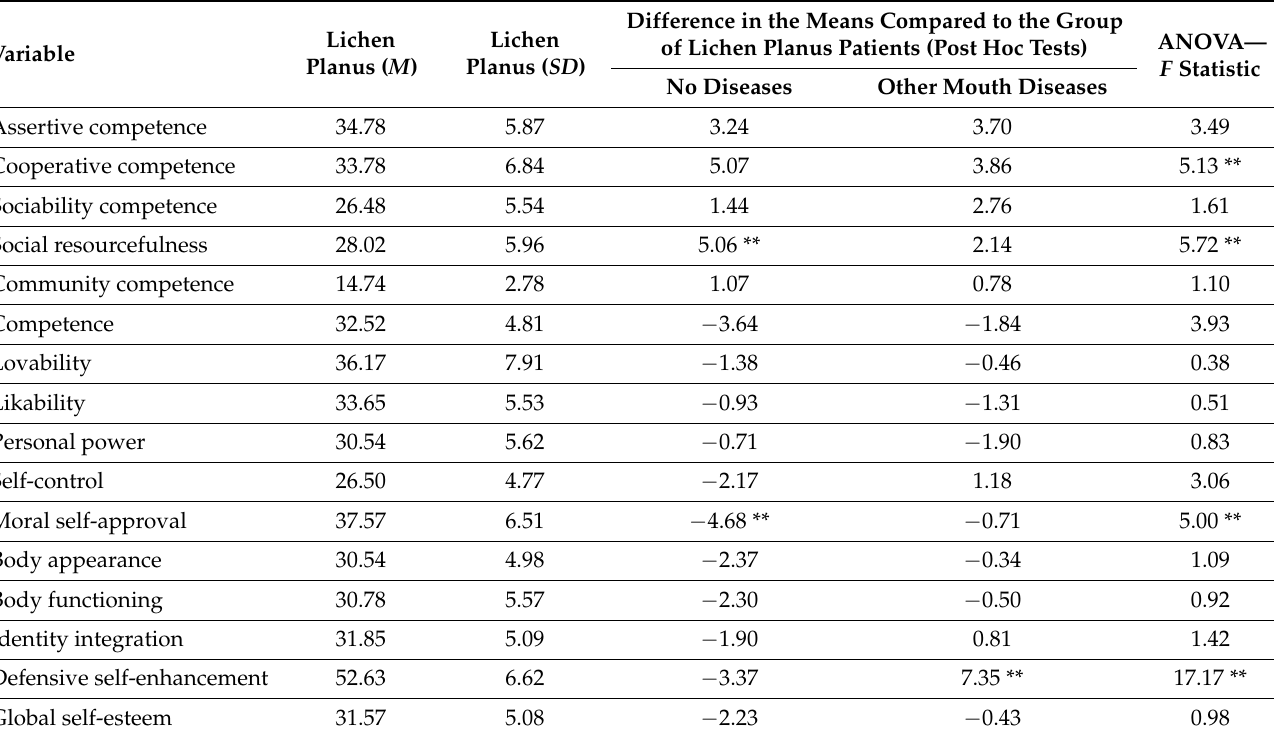
Table 4. Comparison of mean results of patients with lichen planus with other respondents— multidimensional